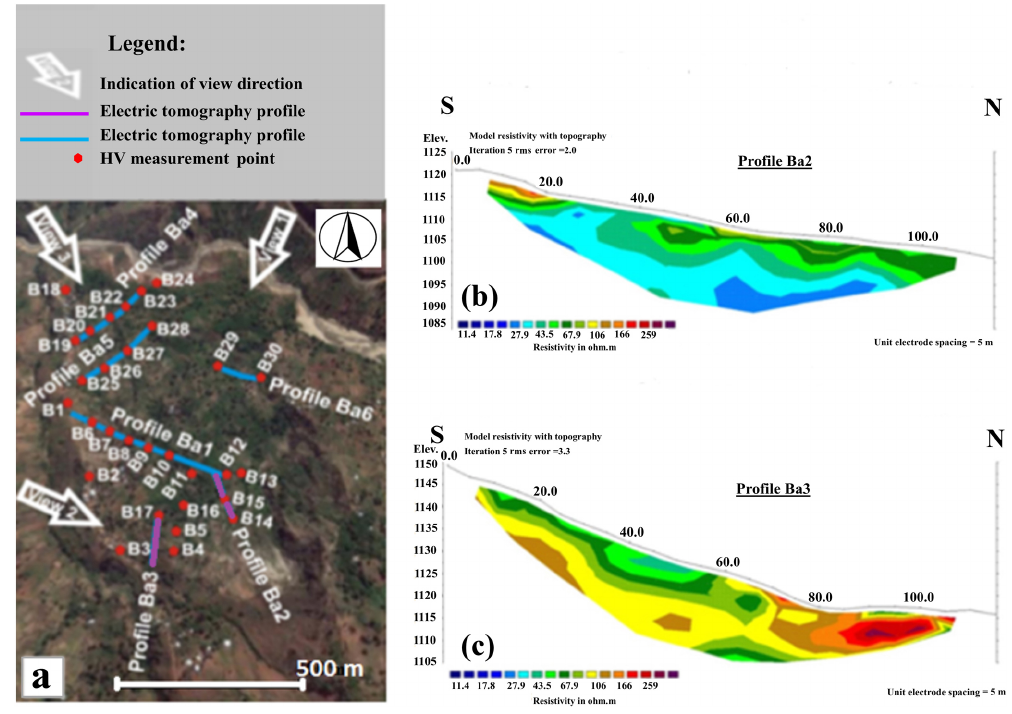
Figure 5. The Banana Tree Landslide field measurements: overview of ERT and HV measurement locations (a) , ERT profiles Ba2 (b) and Ba3 (c) . In panel (a) , Ba2 and Ba3 profiles are highlighted in purple.